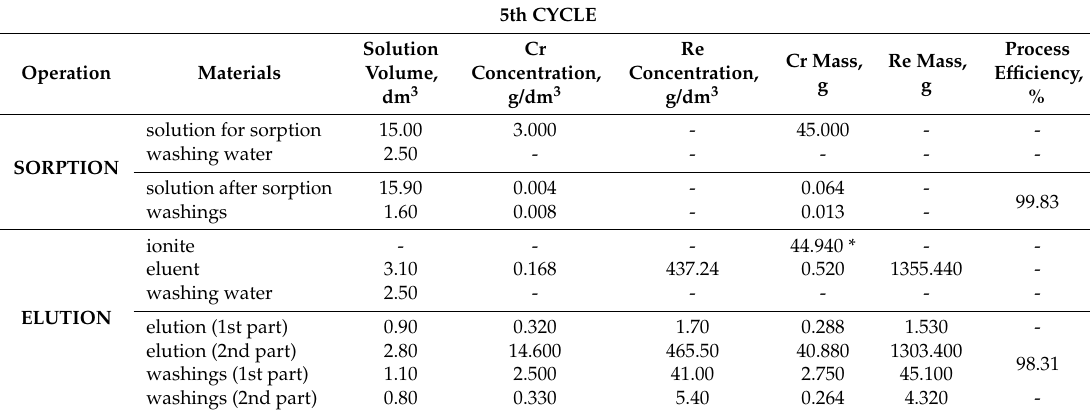
Table 5. Chromium(III) sorption and elution balance—5th cycle. 5th CYCLE